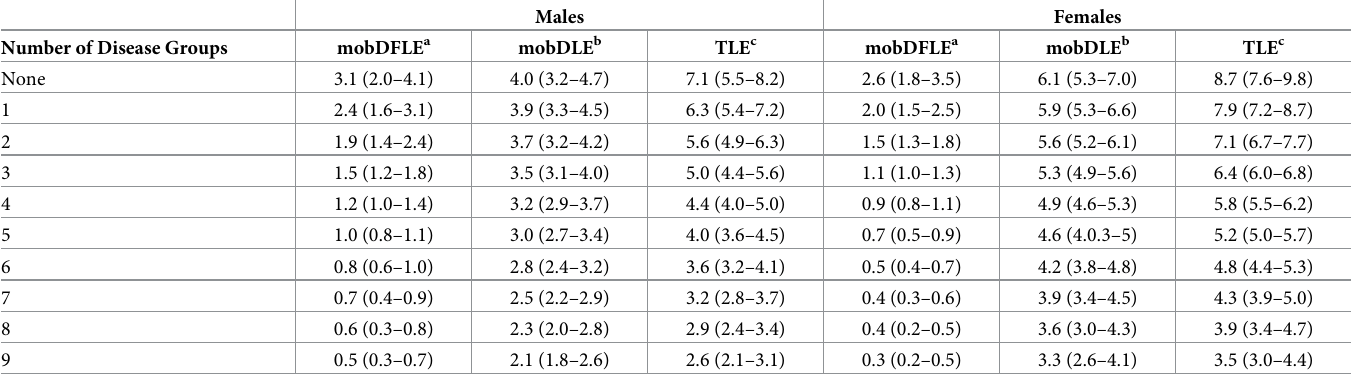
Table 3. Point estimates with 95% confidence intervals for remaining life expectancy (in years) spent with and without mobility disability for each disease group count, in male and female participants at age 85. Males Females Number of Disease